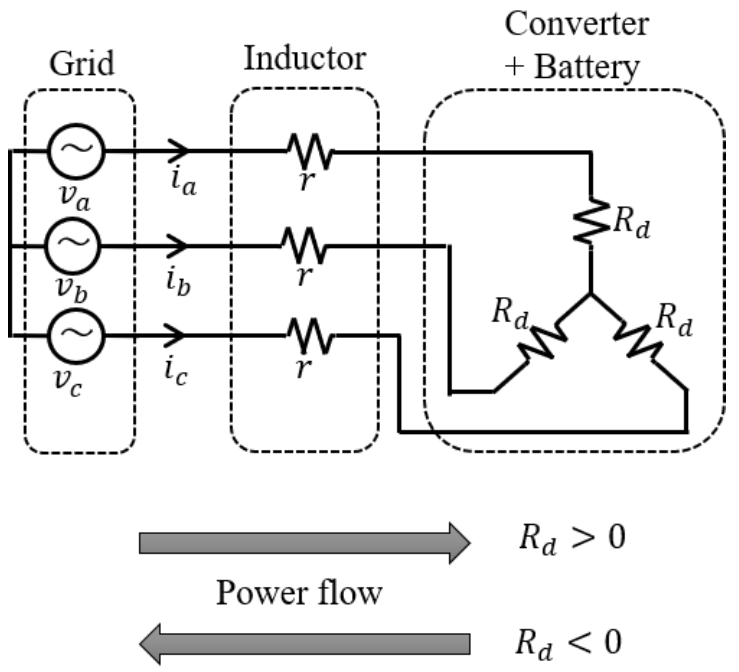
Figure 3. The equivalent resistive model of the proposed